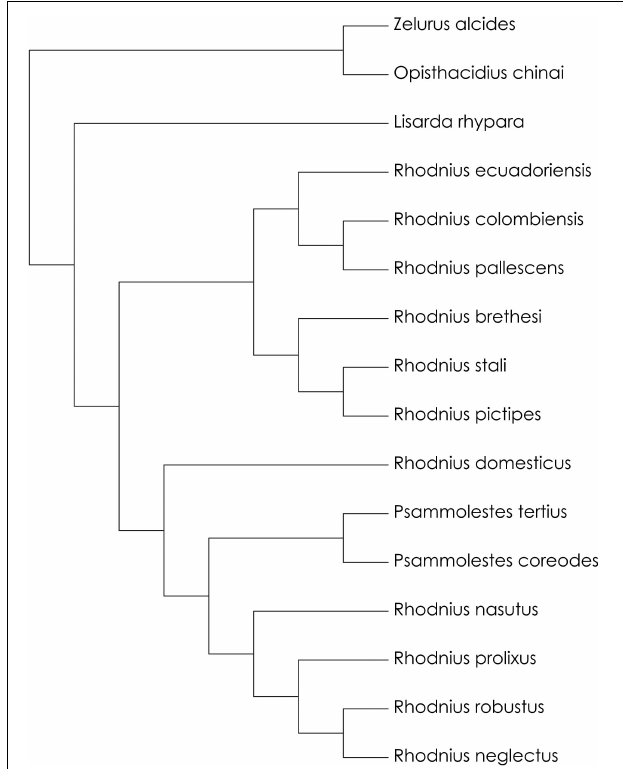
FIGURE 2 | The topology of the maximum likelihood analysis combining 16S + 28S + wingless sequences (–ln L = 5895.714, AIC = 11833.428). It was used PAUP 4.0 in the phylogenetic analysis to derive trees based maximum likelihood